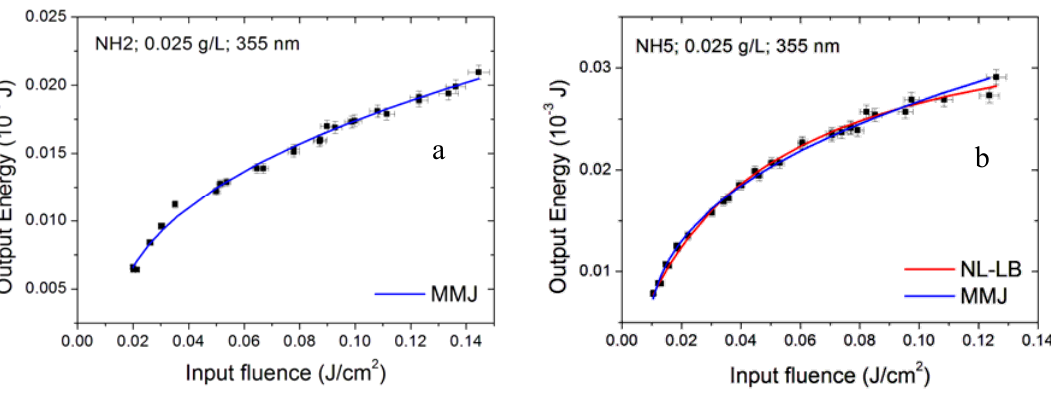
Figure 18. Optical limiting data and semi-empirical modelling for samples NH2 ( a ) and NH5 ( b ) under 355 nm radiation and at 0.025 g/L nanoparticle concentration.